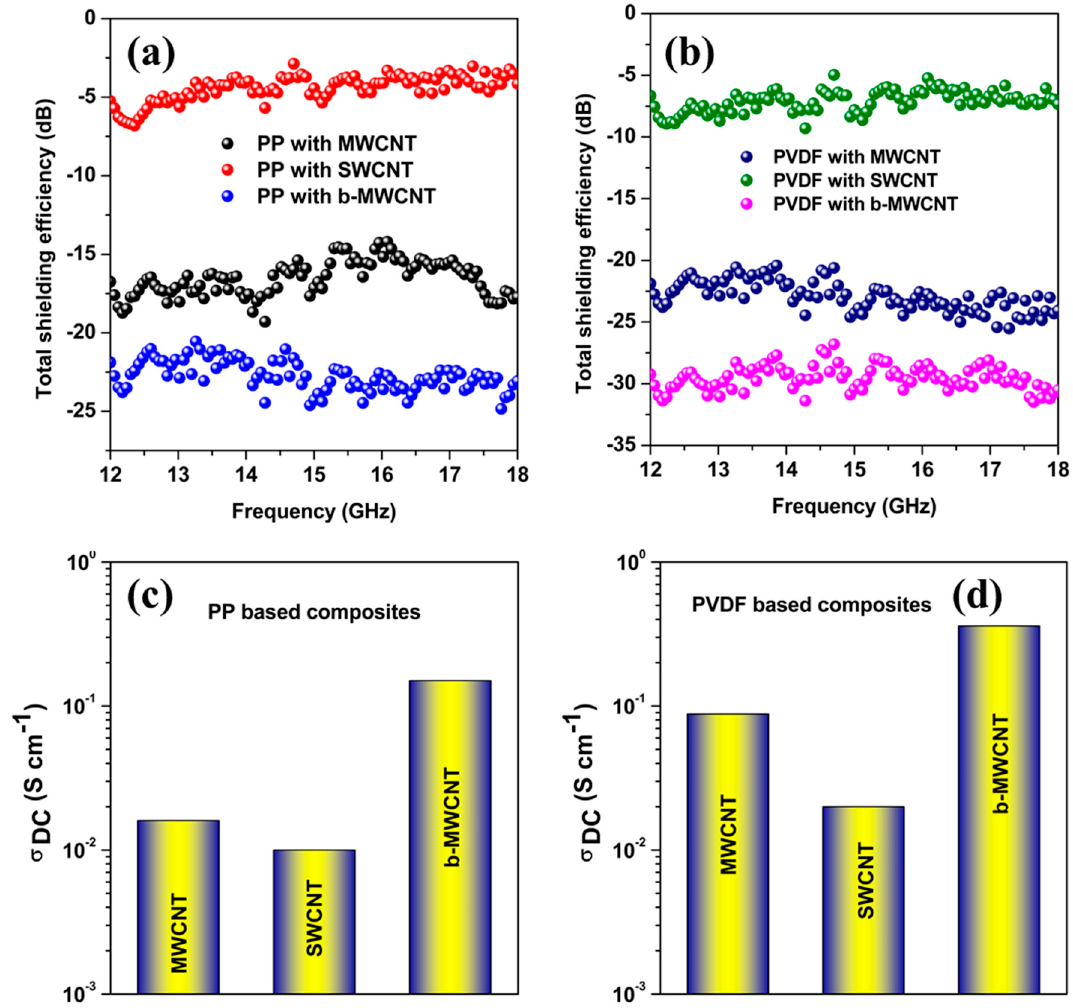
Figure 8. Total electromagnetic shielding efficiency of samples with a thickness of 1 mm for ( a ) PP based and ( b ) PVDF based composites, and ( c ) DC electrical conductivity of PP and ( d ) PVDF based composites. All composites contain 2 wt % CNT.